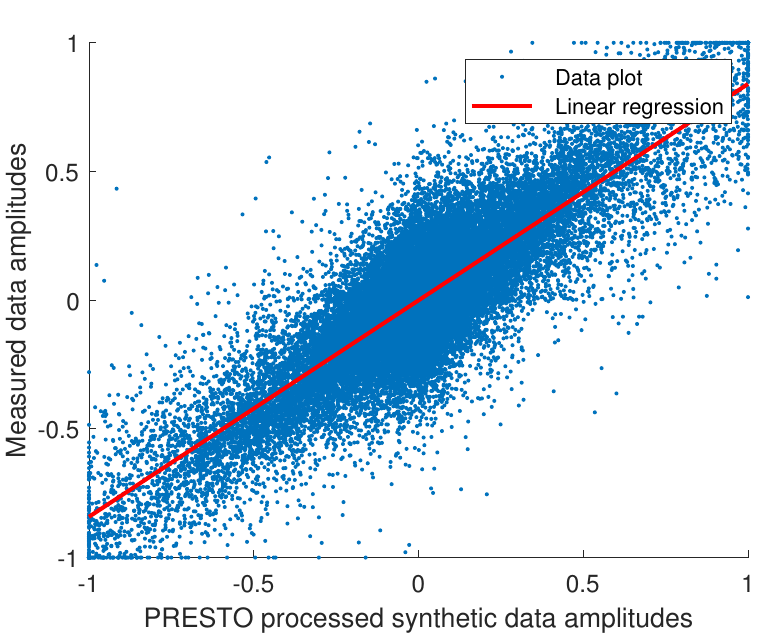
Figure 13. Data fit of real vs. synthetic data processed with the PRESTO technique calculating both modes simultaneously.